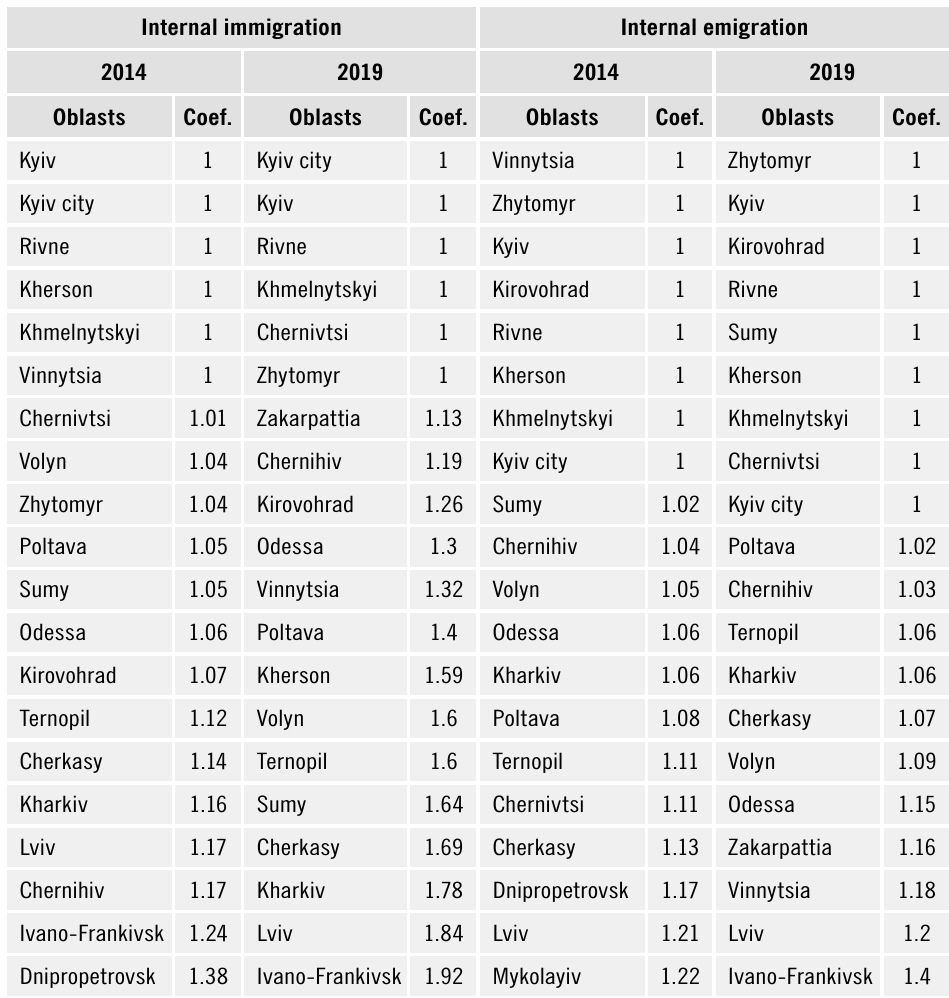
Table 4. Ranking of Ukrainian oblasts by their labor markets attractiveness for internal emigration and immigration processes in 2014 and